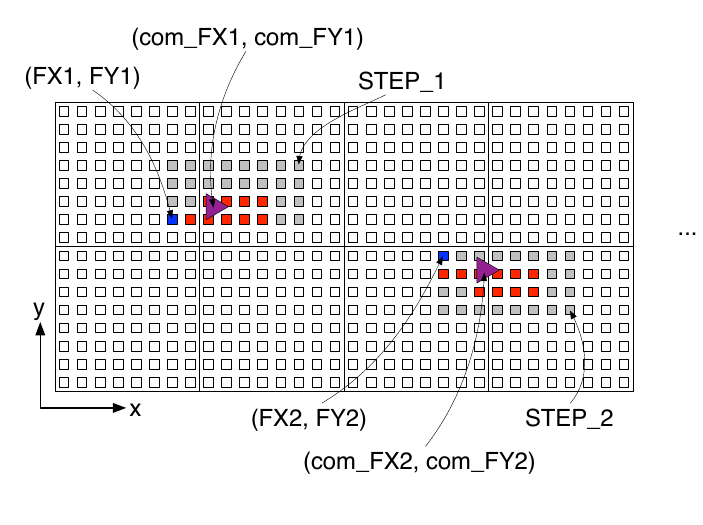
Figure 8. Walking feature